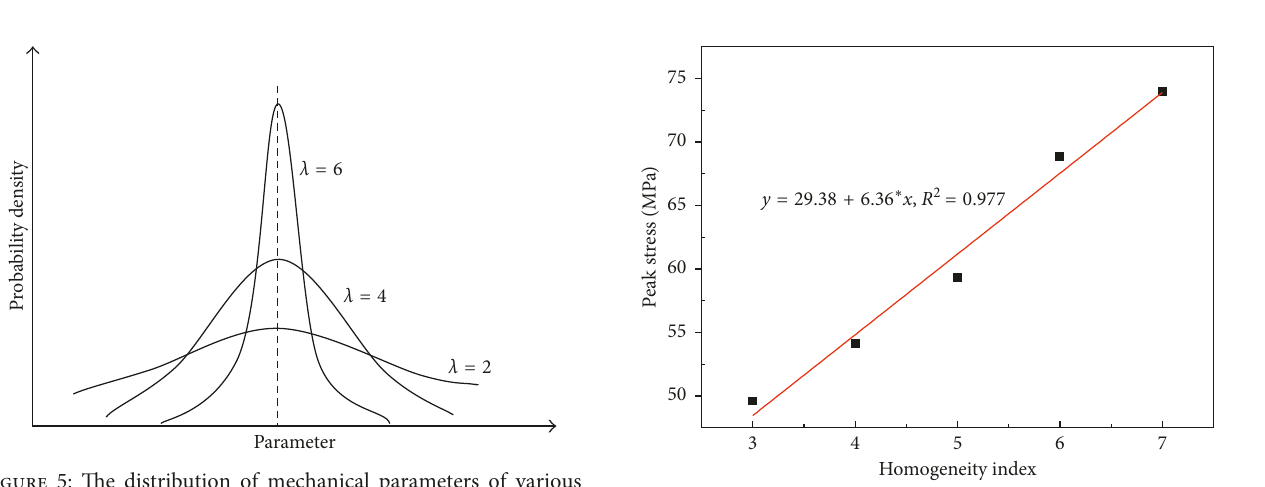
Figure 4: Damage evolution of the sample during the uniaxial compressive test.